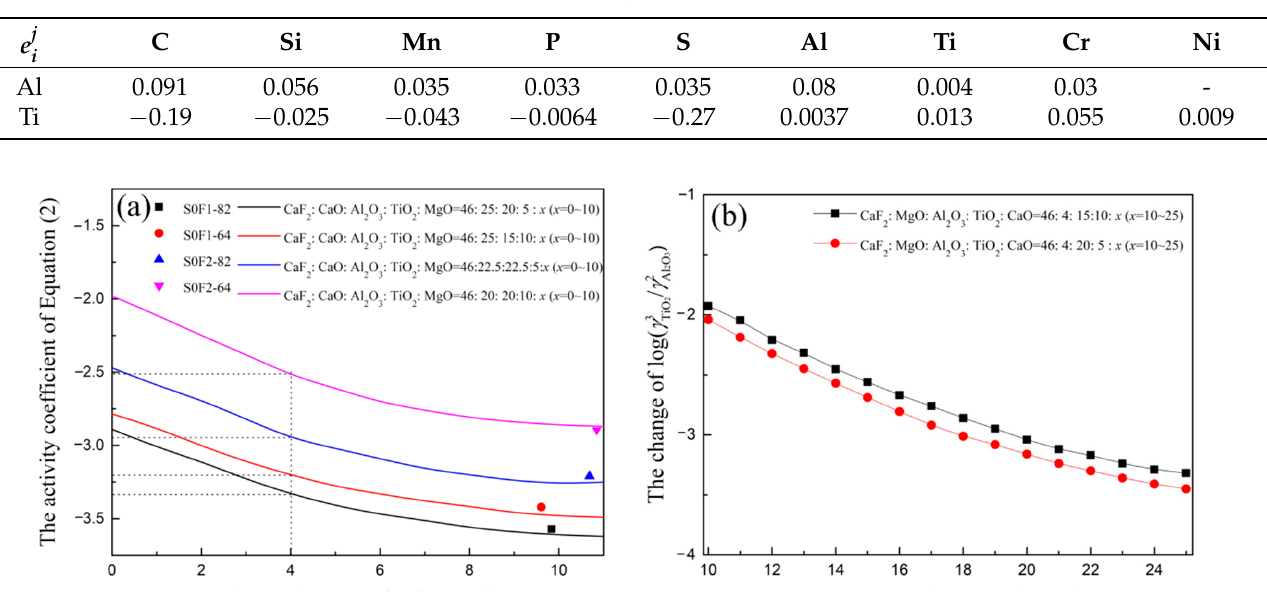
Table 5. Activity interaction coefficient e j